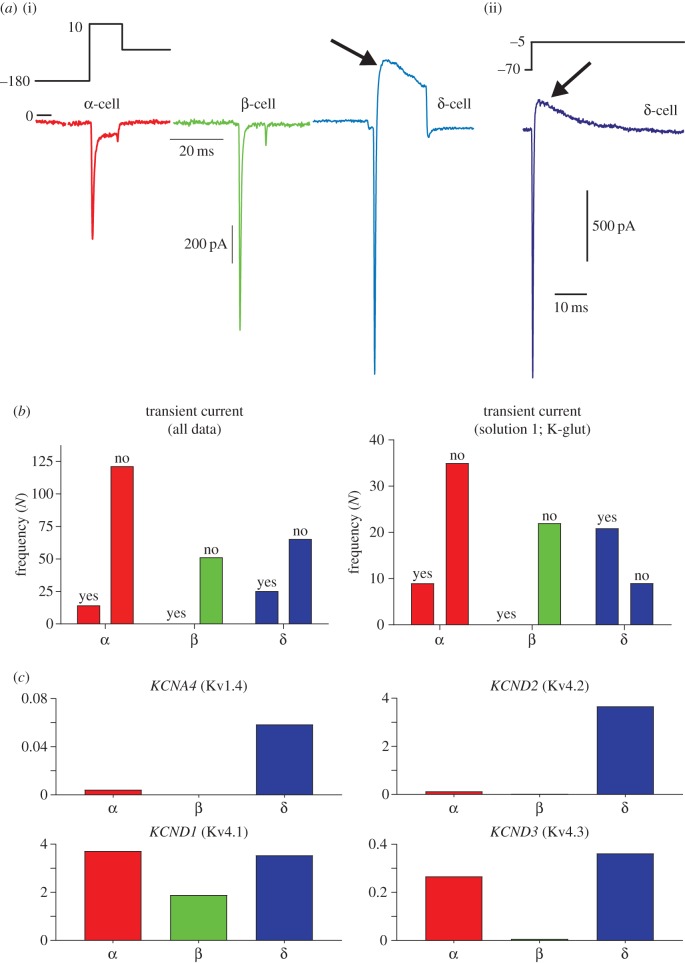
The A-type channel is expressed in both α- and δ-cells. (a) The presence of a transient outward current (arrow) was characterized in each of the 288 cell recordings. (b) The presence of a transient outward current (A-type) was not a feature unique to α-cells; it was actually most prevalent in δ-cells. N = 288 recordings. (c) For each cell type, we represented the number of cells that did (yes) and did not (no) exhibit A-type currents in recordings made in intracellular solution 1 (K-glut) only. N = 93 recordings. (d) The genes encoding TEA-resistant Kv channels of A-type (fast inactivating) are differentially expressed in both α-cells and δ-cells. Transcriptome data from DiGruccio et al. [59], reproduced with permission. (Online version in colour.)